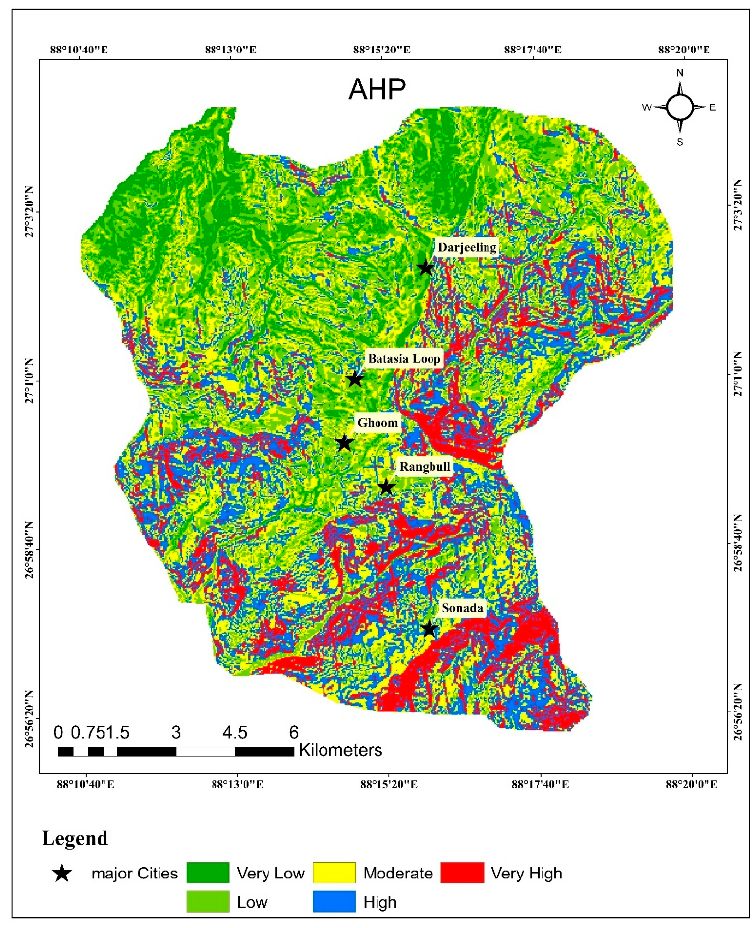
Figure 6. Landslide susceptibility map using Figure 6. landslide susceptibility map using AHP.